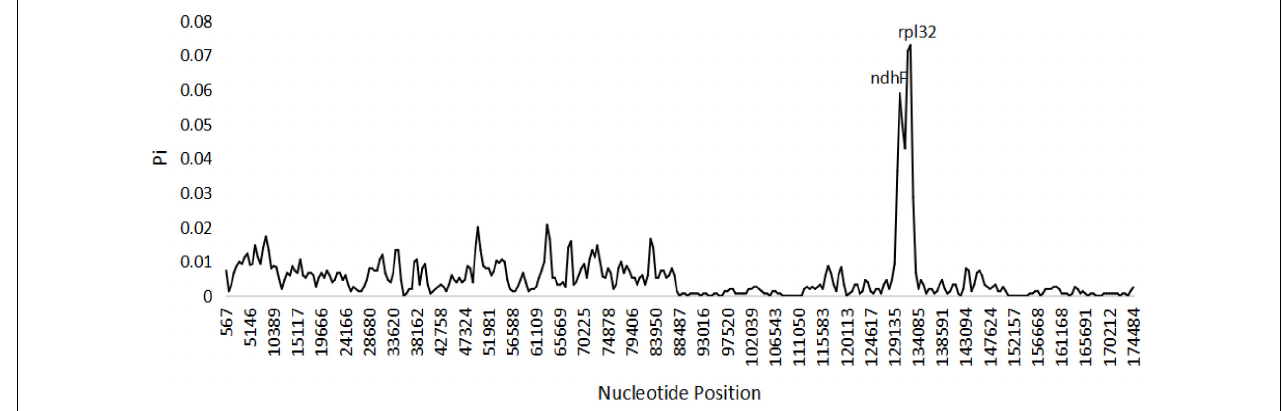
FIGURE 5 | Sliding window analysis of the complete chloroplast genome sequences among three species of Edgeworthia (Window length: 1000 bp; step size: 500